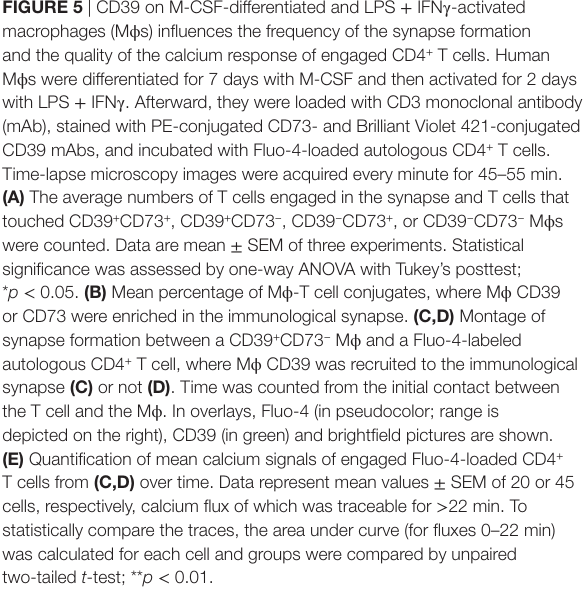
FigUre 5 | CD39 on M-CSF-differentiated and LPS + IFN γ -activated macrophages (M ϕ s) influences the frequency of the synapse formation and the quality of the calcium response of engaged CD4 + T cells. Human M ϕ s were differentiated for 7 days with M-CSF and then activated for 2 days with LPS + IFN γ . Afterward, they were loaded with CD3 monoclonal antibody (mAb), stained with PE-conjugated CD73- and Brilliant Violet 421-conjugated CD39 mAbs, and incubated with Fluo-4-loaded autologous CD4 + T